Question: Which visualization type does this figure use?
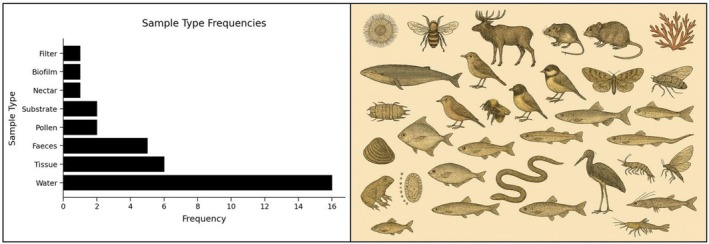
Answer: bar